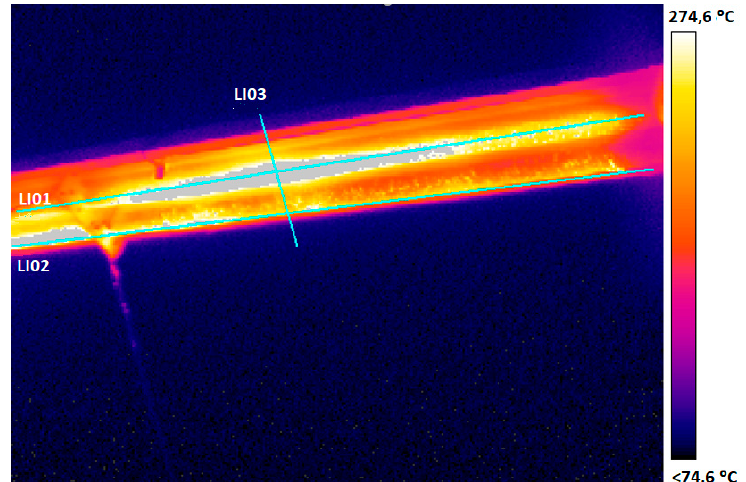
Figure 25. Receiver thermal